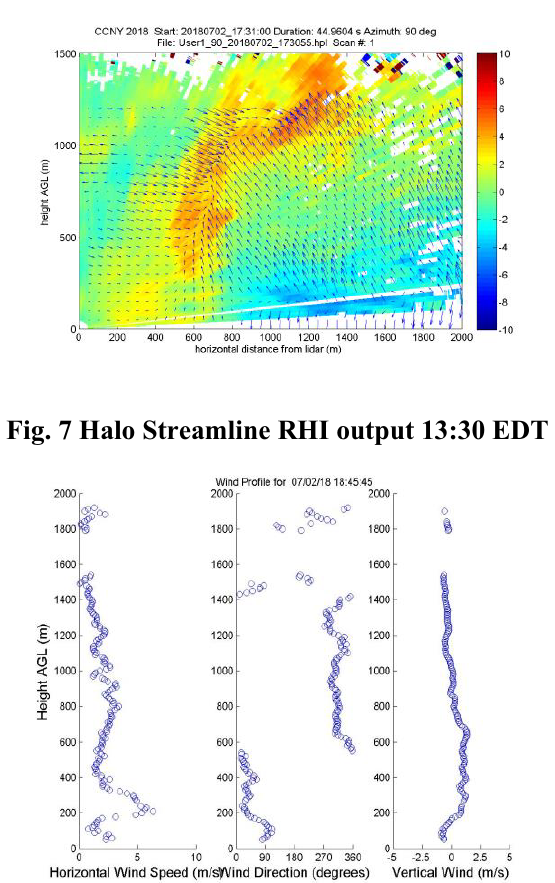
Fig. 8a Halo Pro profiles at 13:45 EDT